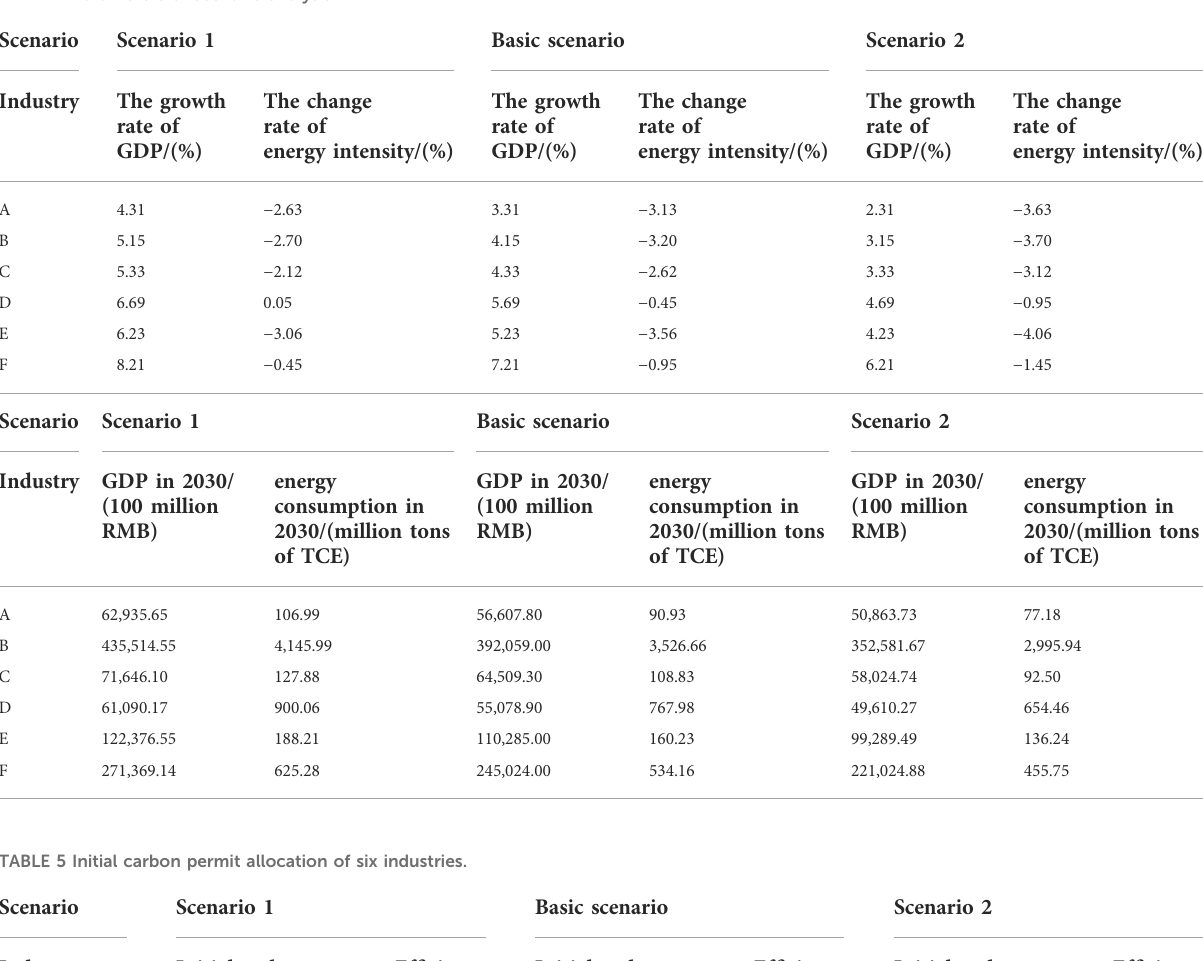
TABLE 4 Parameters of scenario analysis.